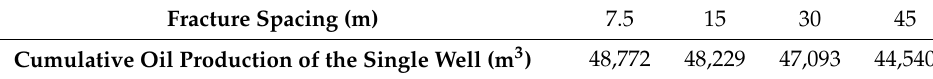
Figure 19. Comparison of cumulative oil production of the single well in each scheme under different fracture spacing. Table 15. Calculation results of di ff erent fracture spacing.